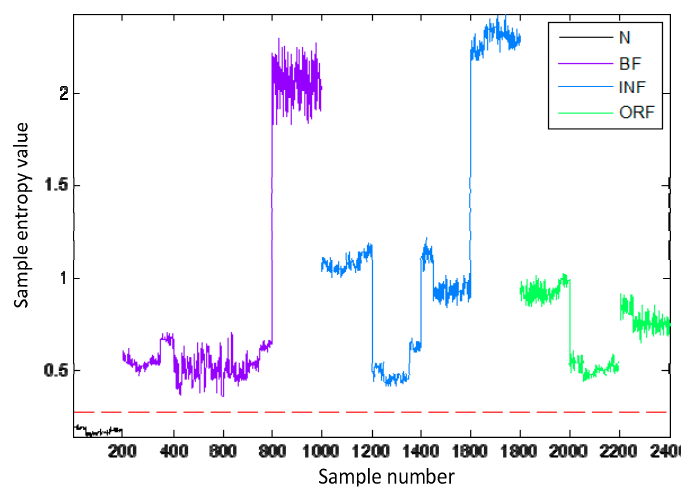
Figure 6. The SampEn values for all 2400 samples under different working conditions.